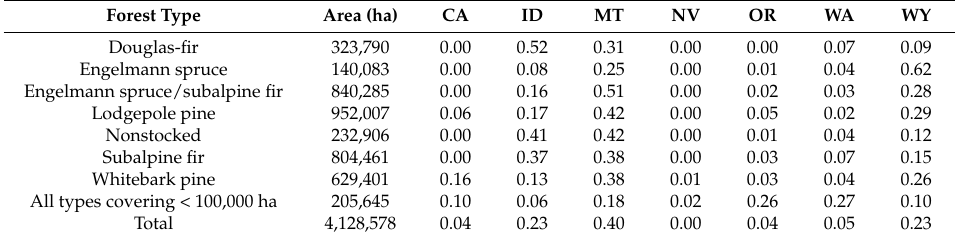
Table 2. Area with a whitebark pine component (live seedling ≥ 15.2 cm tall and <2.54 cm diameter at breast height (DBH), live tree ≥ 2.54 cm DBH, or dead tree ≥ 12.7 cm DBH), by forest type, and proportion of area in each forest type and in each US state.